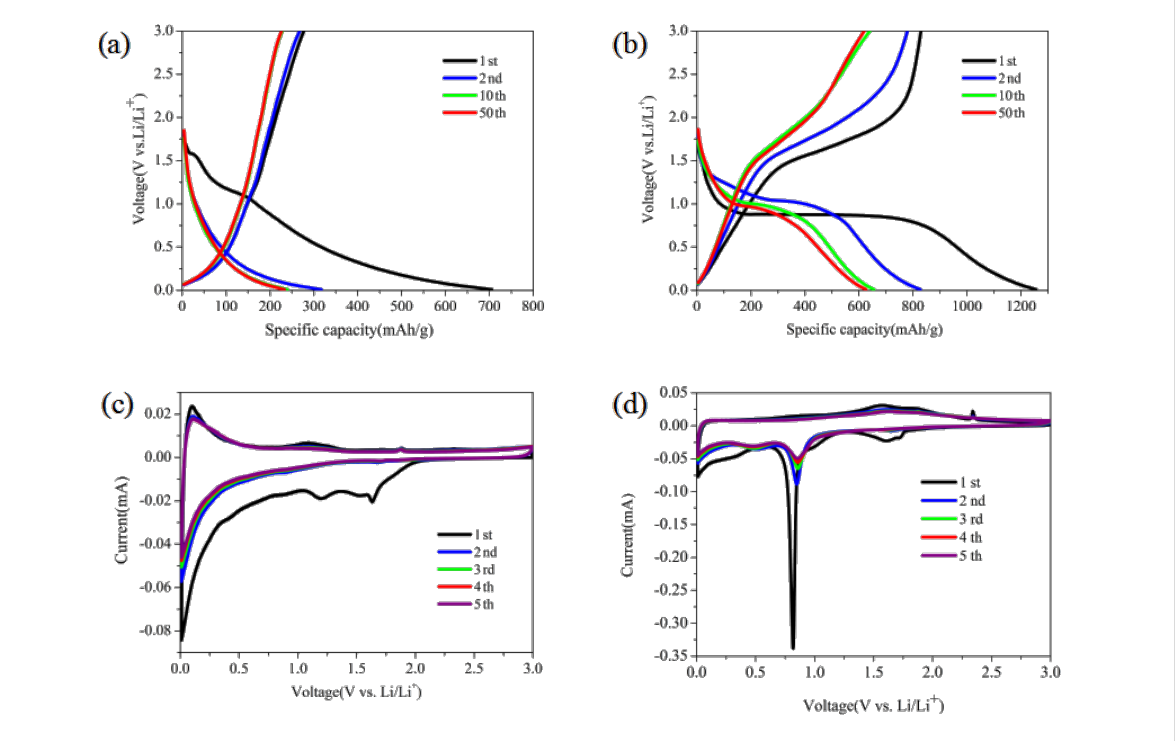
Figure 4: Electrochemical performance of the electrodes: (a) Discharge–charge profiles of COOH-MWCNT at a current density of 500 mA·g − 1 ; (b) discharge–charge profiles of Fe 2 O 3 /COOH-MWCNT composites at a current density of 500 mA·g − 1 ; (c) cyclic voltammograms of COOH-MWCNT at a scan speed of 0.05 mV·s − 1 ; (d) cyclic voltammograms of Fe 2 O 3 /COOH-MWCNT at a scan speed of 0.05 mV·s − 1 .